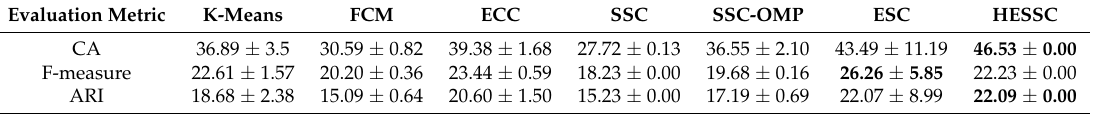
Table 2. Quantitative assessment on the performances of applied clustering algorithms on the second drill-core sample. The evaluation metrics are reported in mean and standard deviation over 10 trials.